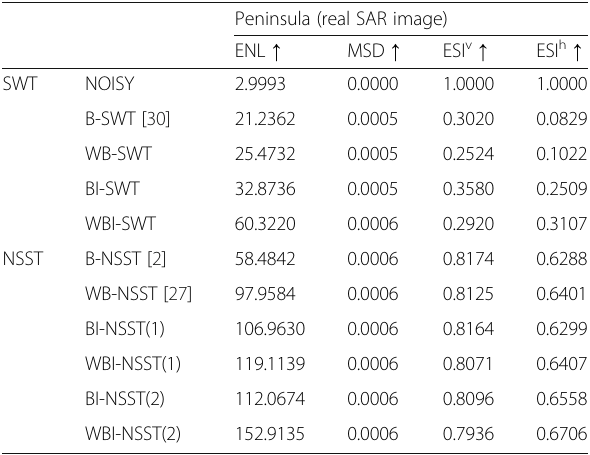
Table 4 Four no reference parameters for Peninsula SAR image to compare with methods in SWT and NSST